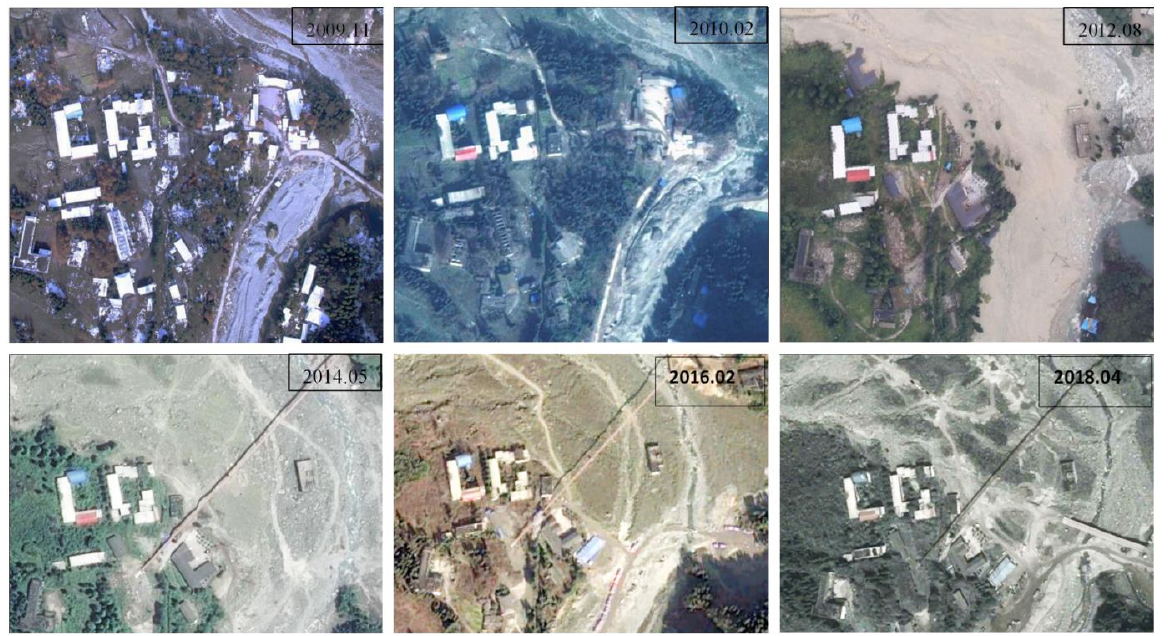
Figure 6. Example of an area experiencing Scenario 2 (Source: Photos taken by the authors from Google Earth and an unmanned aerial vehicle (2009.11).